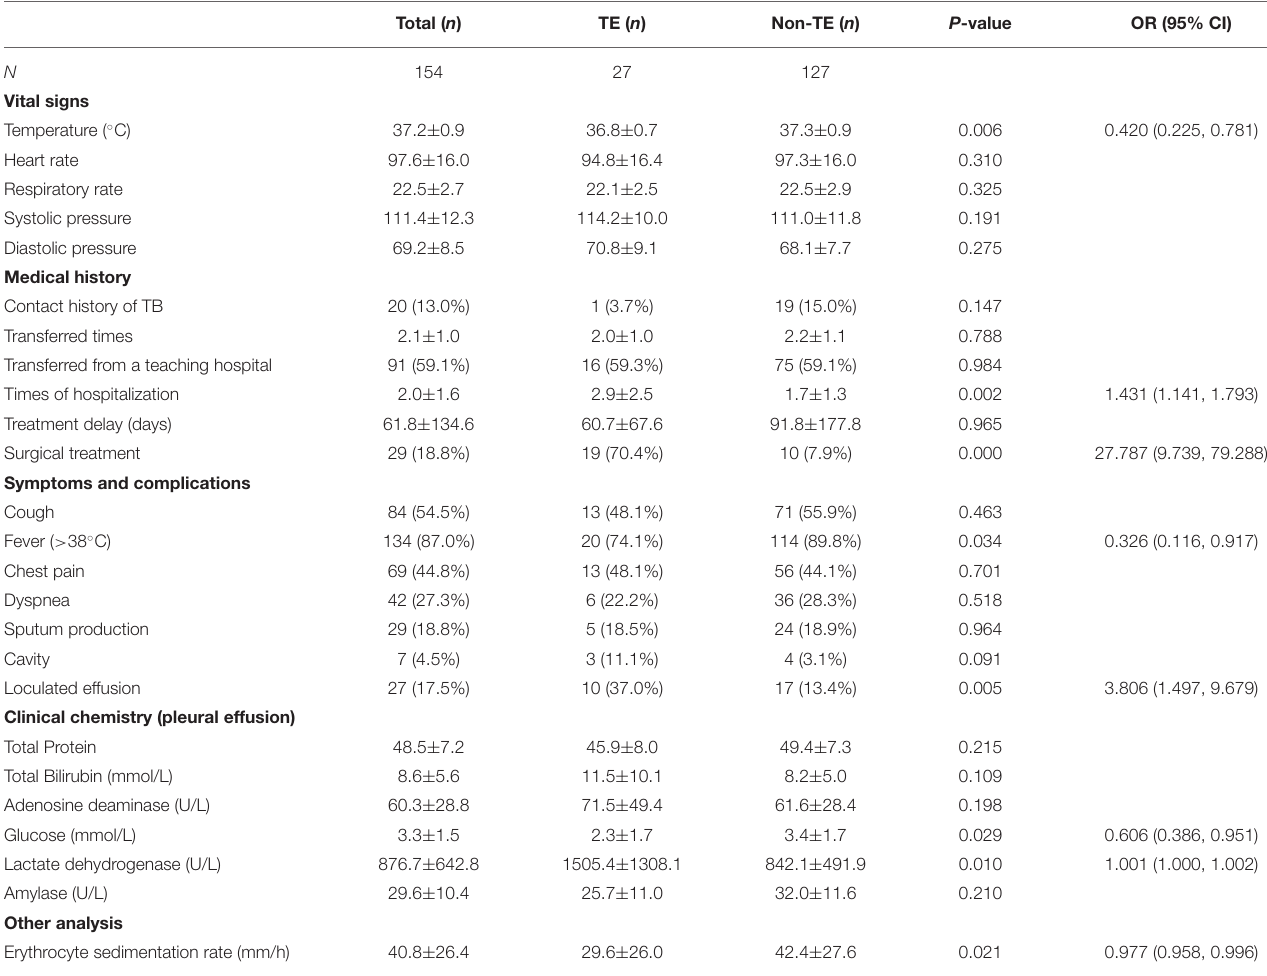
TABLE 1 | Univariate analysis of the demographic data associated with TE in childhood pleural TB. Total ( n ) TE ( n ) Non-TE ( n ) P -value OR (95%